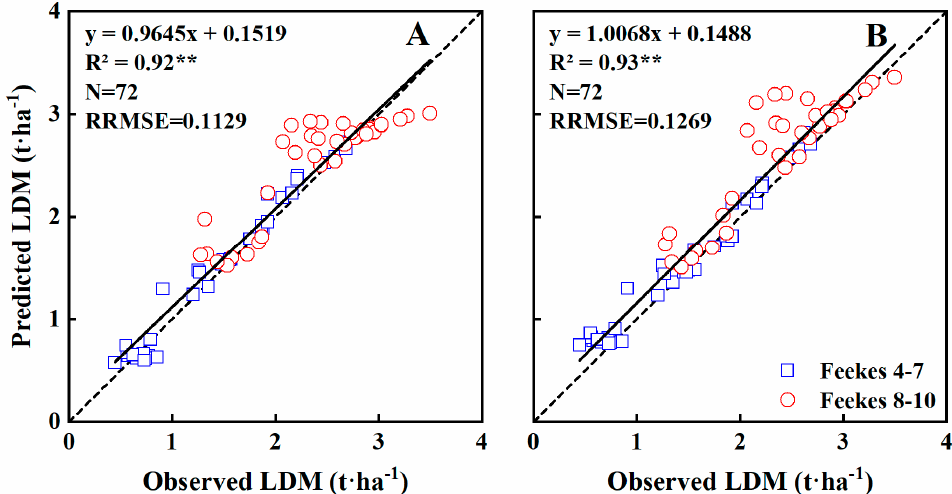
Figure 5. The relationships between observed and predicted LDM values of wheat varieties based on NDVI ( A ) and RVI ( B ) models in the Experiment 4 during vegetation growth period. The dotted line is inclined at 45° to the axes.